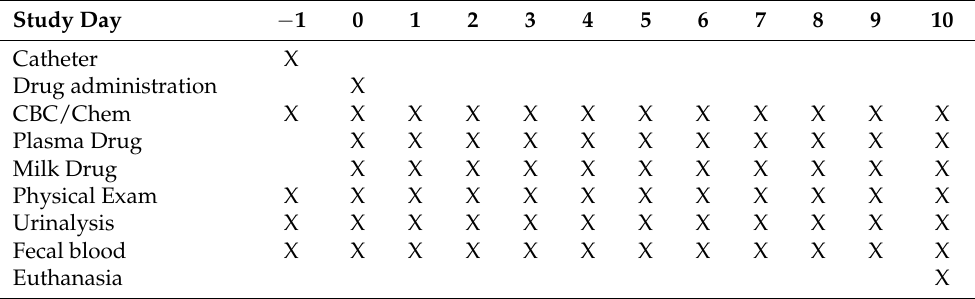
Table 1. Graphical representation of the study design